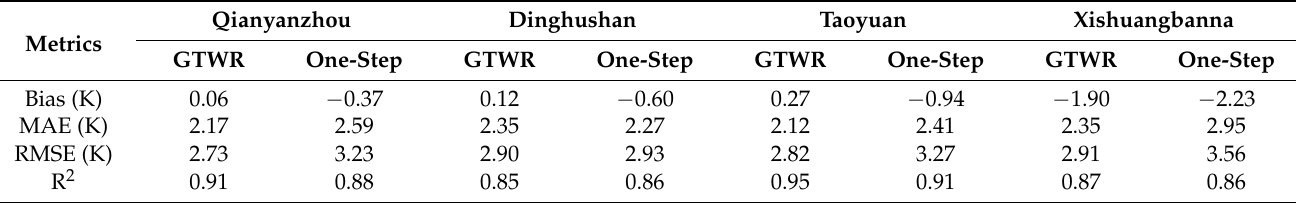
Table 5. Comparisons of the 1 km MLP-GTWR LST (GTWR) and the LST predicted from the MLP model using the directly interpolated AMSR2 BTs data (one-step) against in situ